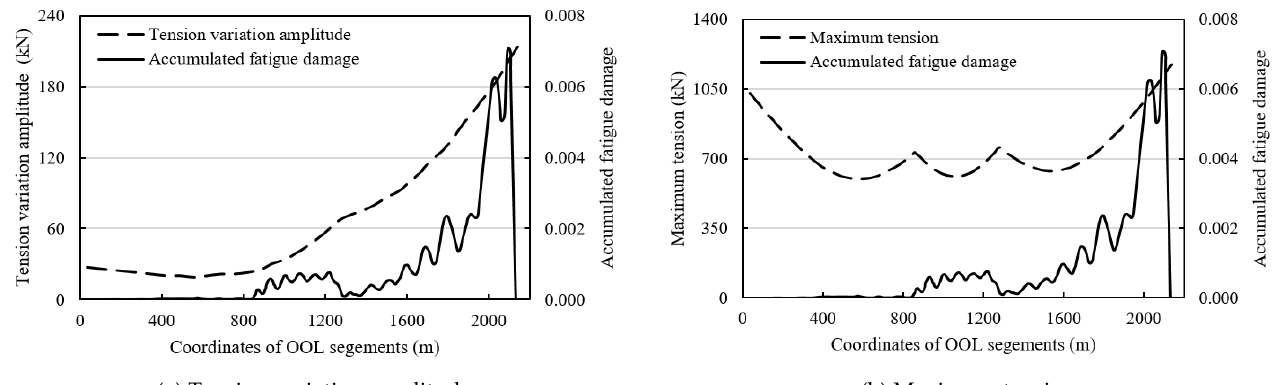
Figure 11. Tension and fatigue damage distribution along the length of OOL.